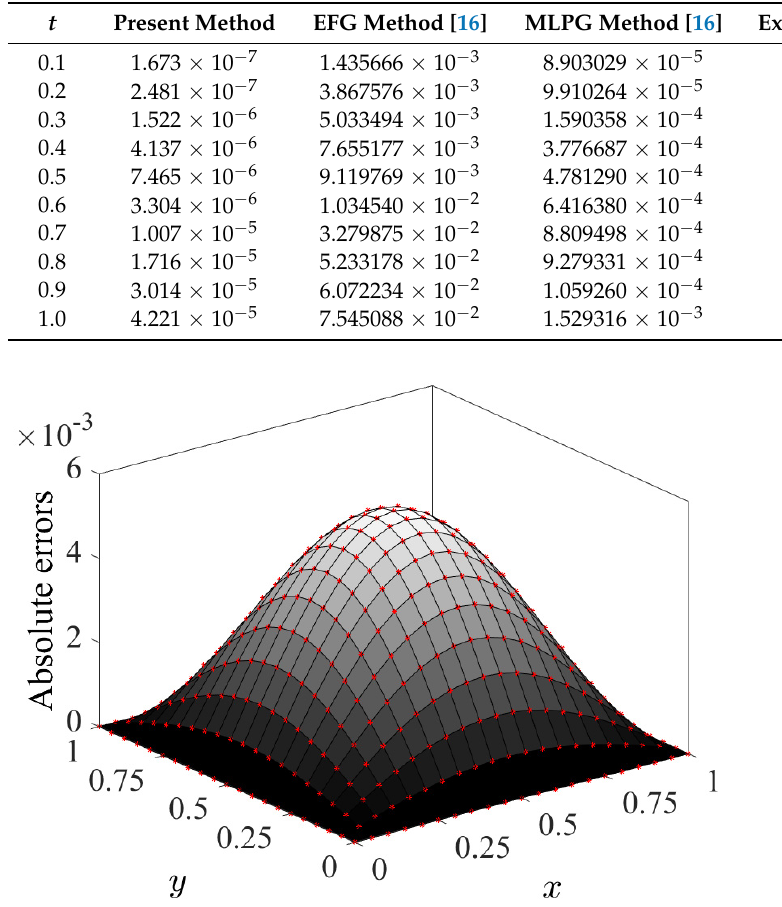
Figure 6. The absolute error norms with h = 0.05 and ∆ t = 0.01 for z = 0.5 at t =